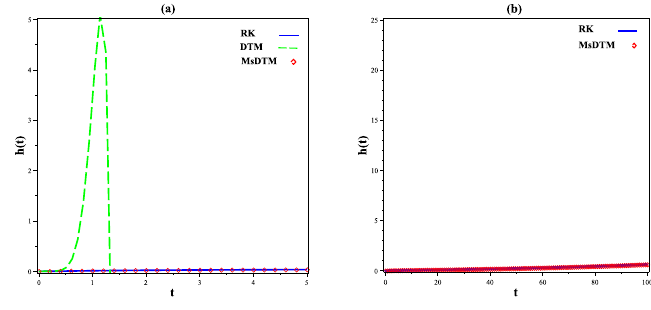
Figure 7: The density of the humans infected with mutant avian influenza with r 0 = 1.06 and R 0 ≈ 3.5 .